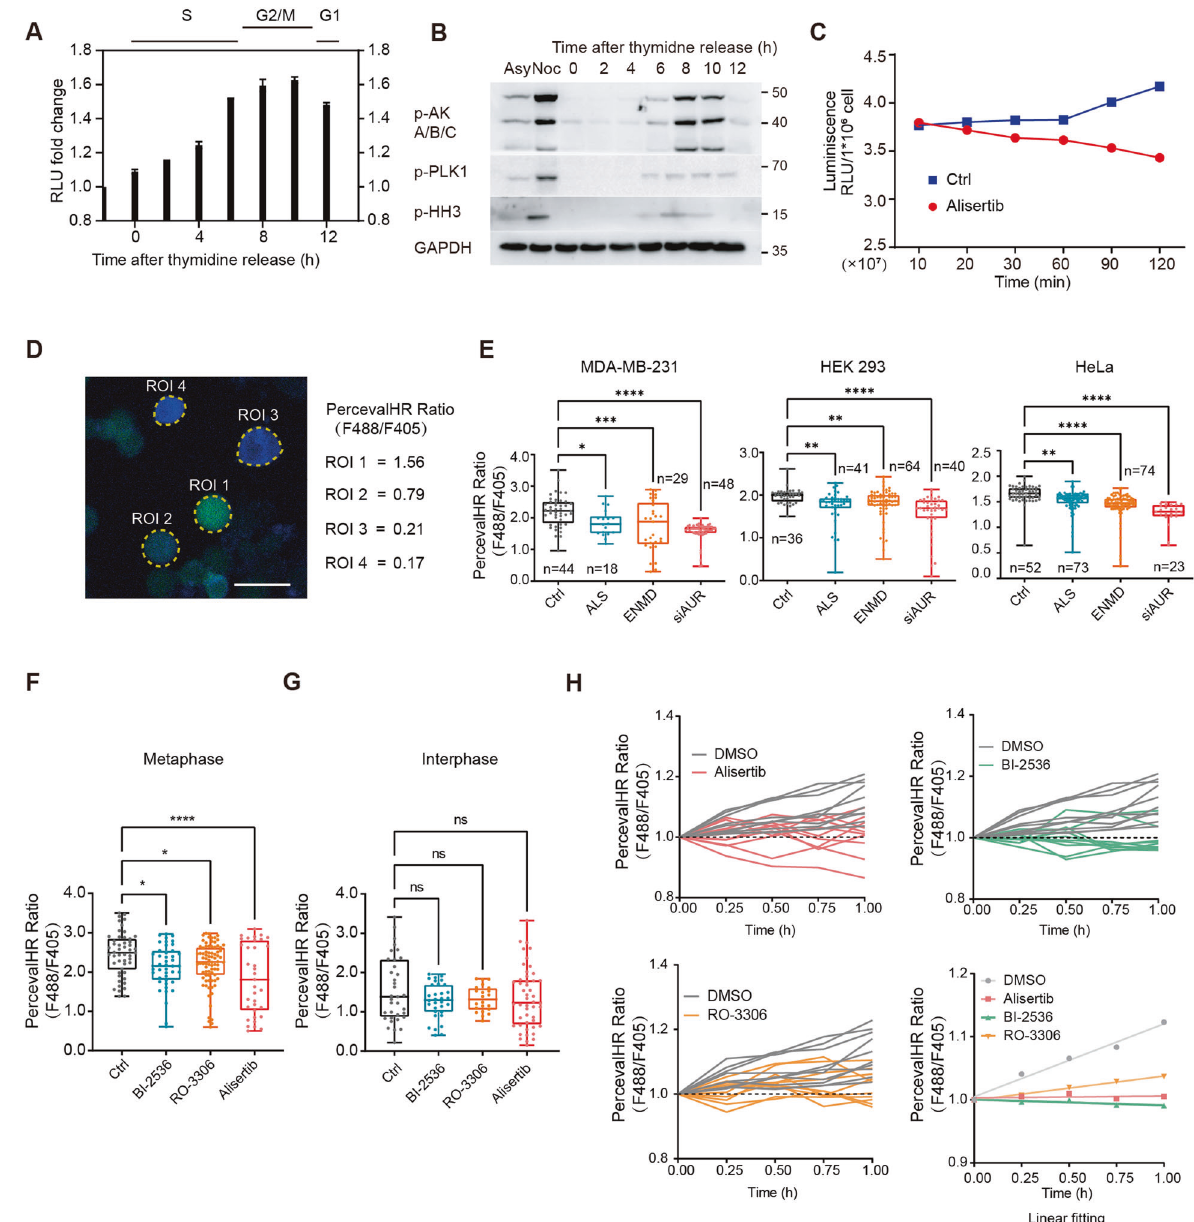
Fig. 2 Mitotic kinase inhibition disrupts cellular energy homeostasis during mitosis. A ATP bioluminescent assay measuring relative ATP levels in cells released at indicated time points from a double-thymidine block. Asynchronized cells were used as controls. Mean ± SD; n = 3. B Analysis of the cell-cycle progression in MDA-MB-231 cells released from a double-thymidine block using p-HH3 (Phospho Histone H3 (S10)), p-AKA/B/C (Phospho-Aurora A (Thr288)/Aurora B (Thr232)/Aurora C (Thr198)), and p-PLK1 (Phospho-PLK1 (Thr210)). Asynchronized and nocodazole-synchronized mitotic cells were used as controls. C The relative ATP levels of mitotic cells were measured at the indicated time points after 100 nM alisertib treatment. Intracellular ATP levels were detected by ATP bioluminescent assay; n = 3. D Representative images of PercevalHR-expressing MDA-MB-231 cells synchronized in mitosis by nocodazole. The sensor bound to ATP (green), ADP (blue), or PercevalHR ratiometric signal is demonstrated. Scale bar, 25 µm. E PercevalHR ratio in mitotic cell cells after 2 h treatment with vehicle control (Ctrl), 100 nM alisertib (ALS), 5 μ M ENMD-2076 (ENMD), or siRNA targeting Aurora-A (siAUR). * p < 0.05; ** p < 0.01; *** p < 0.001; **** p < 0.0001. By one-way ANOVA. F Quanti fi cation of pH-corrected PercevalHR ratiometric signal in single cells synchronized at mitosis. All samples were treated for 2 h with vehicle control (Ctrl), 100 nM BI-2536, 10 μ M RO-3306, or 100 nM alisertib in a complete growth medium before imaging. ns not signi fi cant; * p < 0.05; *** p < 0.001; **** p < 0.0001. By one-way ANOVA. Mean ± SD, ( n = 50: Ctrl; n = 43: B; n = 80: R; n = 35: A). G Quanti fi cation of pH- corrected PercevalHR ratiometric signal in interphase cells. All samples were treated as in Fig. 2F and analyzed by one-way ANOVA. ns not signi fi cant. Mean ± SD, ( n = 35: Ctrl; n = 32: B; n = 22: R; n = 48: A). H Live imaging of PercevalHR expressing cells synchronized at mitosis. Quanti fi cation of intracellular F488/F405 (ATP/ADP) ratios in single cells incubated in DMEM with vehicle control (DMSO), BI-2536, RO-3306, or alisertib. (Lower right) Linear fi tting of F488/F405 (ATP/ADP) ratios at different time points. (The experiment was conducted on the same panel, the same DMSO group is shown in each image; The fi rst recorded ratio was normalized to 1); n = 10.